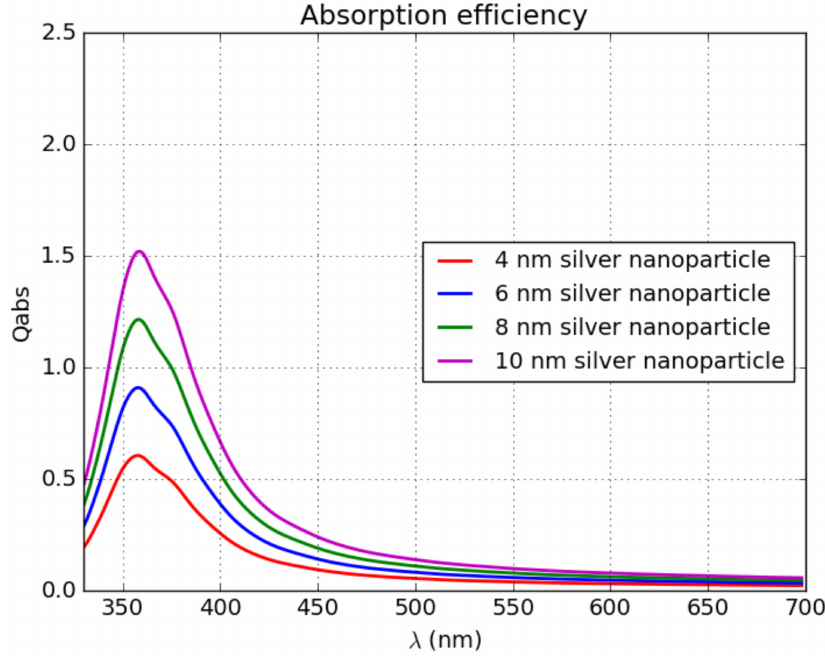
Figure 9. Mie calculation of absorption cross-section of Ag NP in LiF